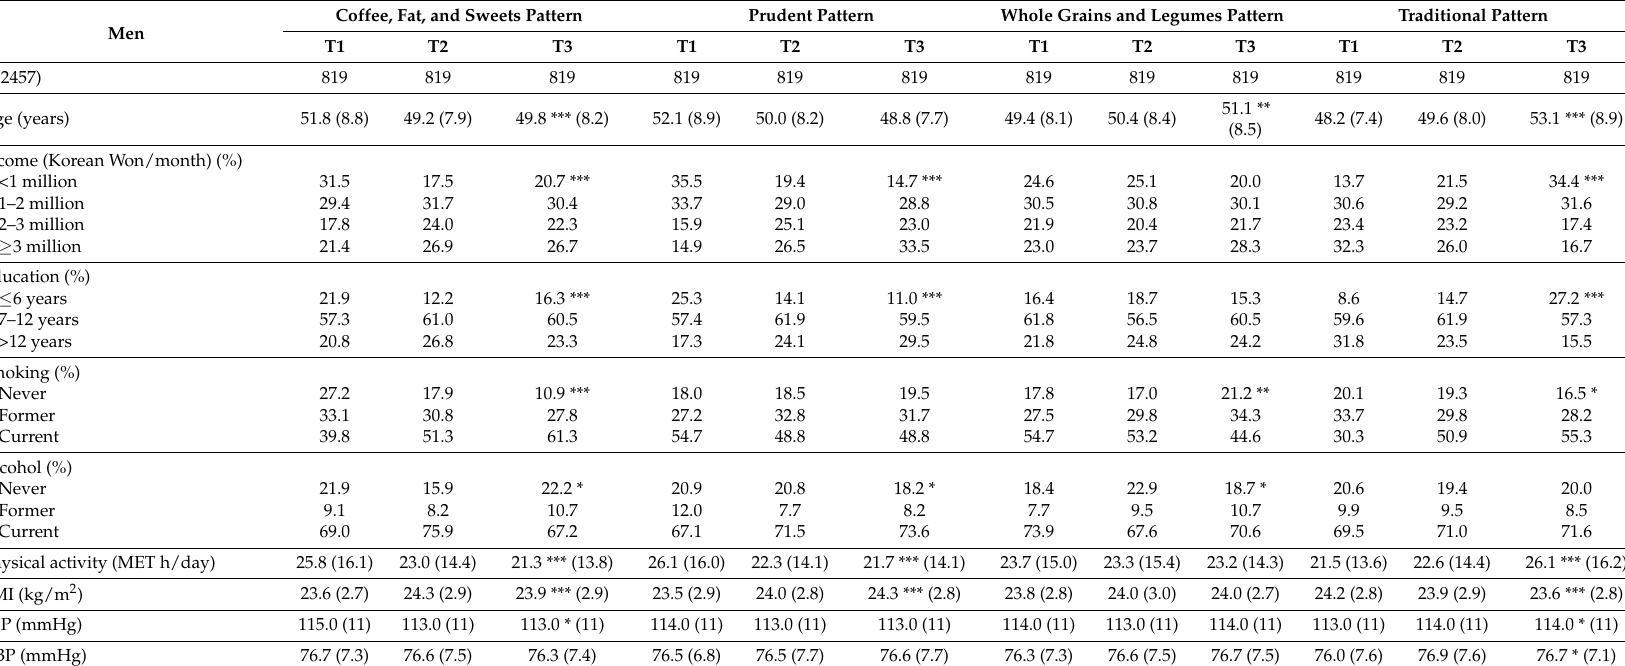
Table 2. Characteristics of the study participants according to the tertiles (T) of dietary pattern scores in men 1,2